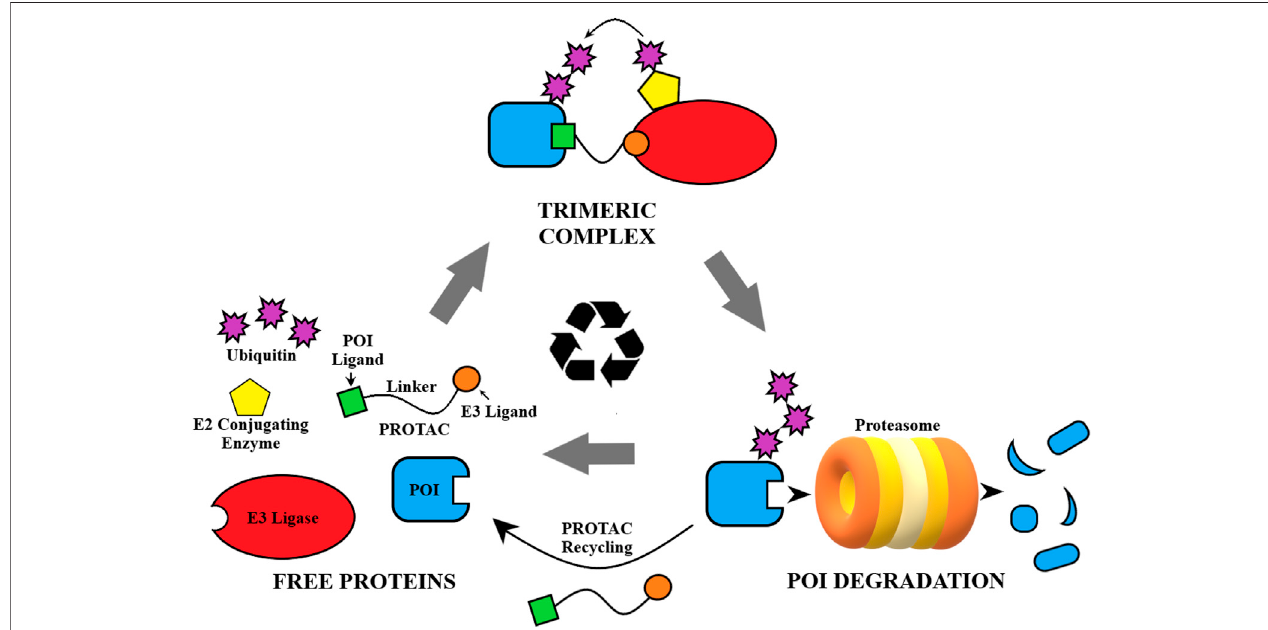
FIGURE 1 | General depiction of the mechanism of action of PROTACs.